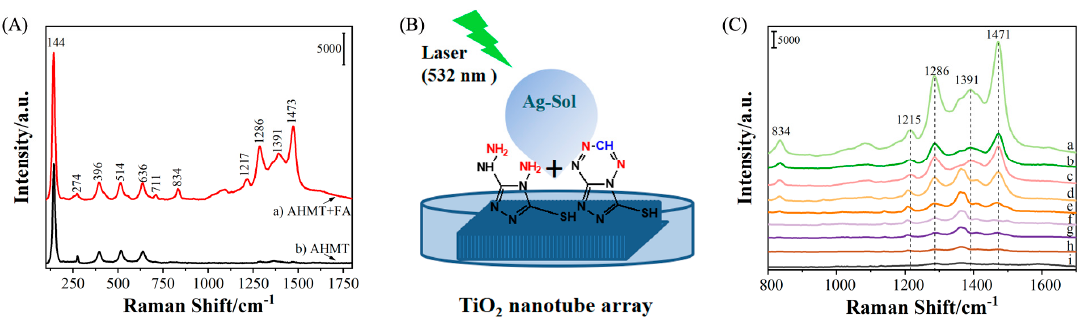
Figure 4. ( A ) Surface-enhanced Raman scattering (SERS) spectra of AHMT and AHMT-FA (6-mercapto-5-triazolo [4,3-b]-s-tetrazine,MTT): ( a ) A mixture of AHMT and MTT (with an excess of AHMT in the reaction.); ( b ) AHMT (3.34 × 10 − 3 M). ( B ) SERS detection process diagram. ( C ) SERS detection of FA (from 1.44 × 10 − 2 to 1.44 × 10 − 9 M) using AHMT as a probe (3.34 × 10 − 3 M) after 16 h of reaction. ( a – h ) FA (1.44 × 10 − 2 –1.44 × 10 − 9 M) + AHMT (3.34 × 10 − 3 M) and ( i ) AHMT (3.34 × 10 − 3 M). Table 1. Vibration modes represented by AHMT-FA characteristic bands. Functional Group /